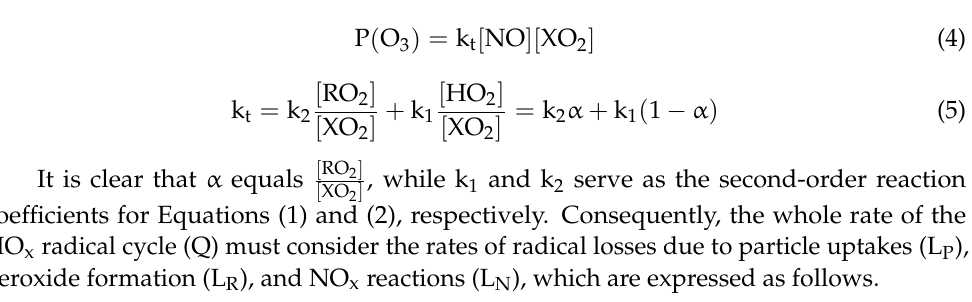
), peroxide formation ( L ), and NO reactions ( L ). Mainly, (cid:2900) (cid:2902) (cid:2934) (cid:2898) ≡ HO + RO ) (Equations (1) and (2)) and the (cid:2870) (cid:2870) (cid:2870)